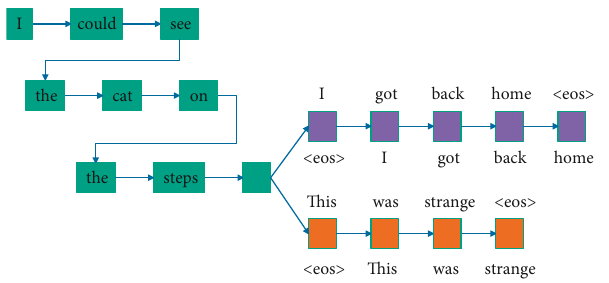
Figure 2: Skip-through network After the model training is over, the output of the last hidden layer on the encoding end is the sentence vector representation. After that, the sentence vector is used as the input of the two classifier.